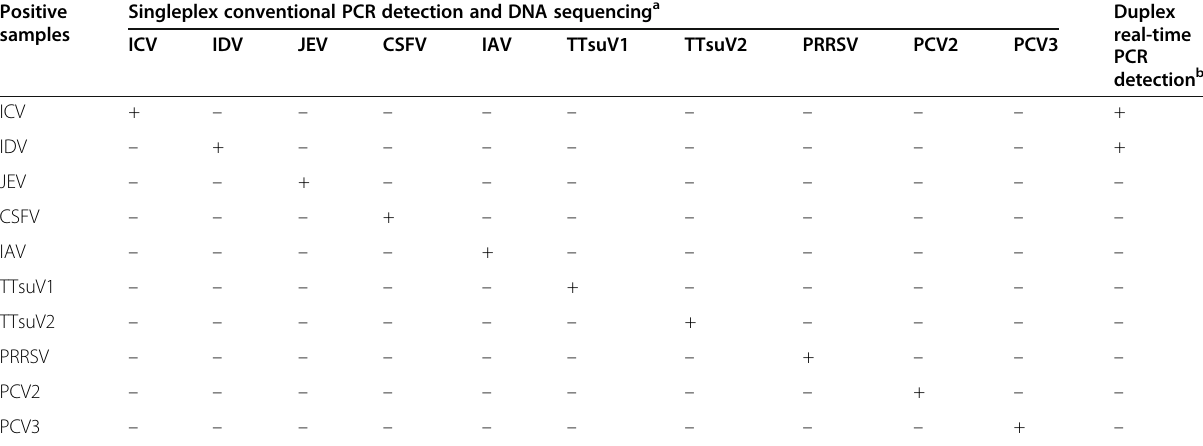
a These samples were detected by conventional PCR and confirmed by DNA sequencing. b Criteria of positivity: Cq ≤ 38, invalid (?); Cq>38 or no signal detected, negative ( − ). PCV2 porcine circovirus type 2, PCV3 porcine circovirus type 3, JEV Japanese encephalitis virus, CSFV classical swine fever virus; IAV influenza A virus,